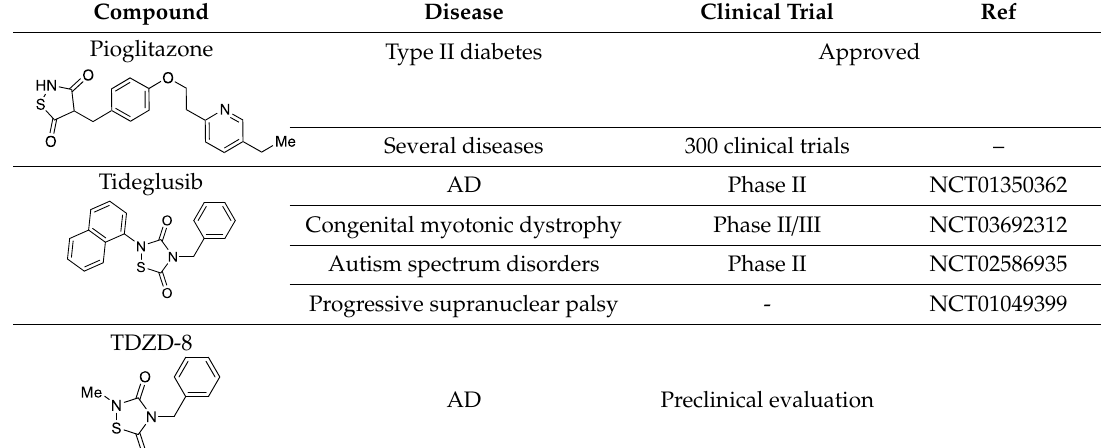
Table 1. GSK-3 β inhibitors with NRF2 induction capacity. Table 1. GSK-3β inhibitors with NRF2 induction capacity. Table 1. GSK-3β inhibitors with NRF2 induction capacity. Table 1. GSK-3β inhibitors with NRF2 induction capacity. Table 1. GSK-3β inhibitors with NRF2 induction capacity. Table 1. GSK-3β inhibitors with NRF2 induction capacity. Table 1. GSK-3β inhibitors with NRF2 induction